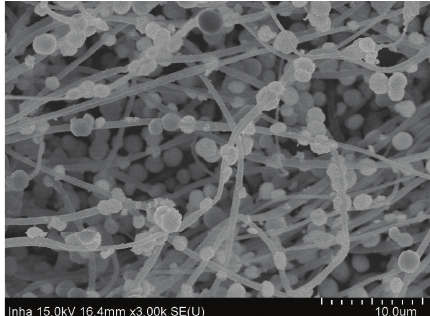
Figure 1: SEM image of polyethylenimine (PEI) nanofibers, loading with BiOCl nanoparticles.